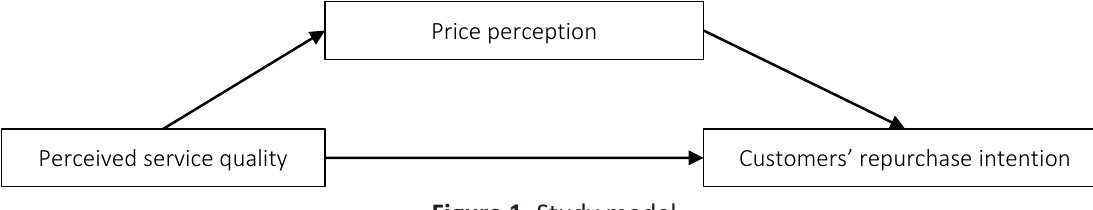
Figure 1. Study model